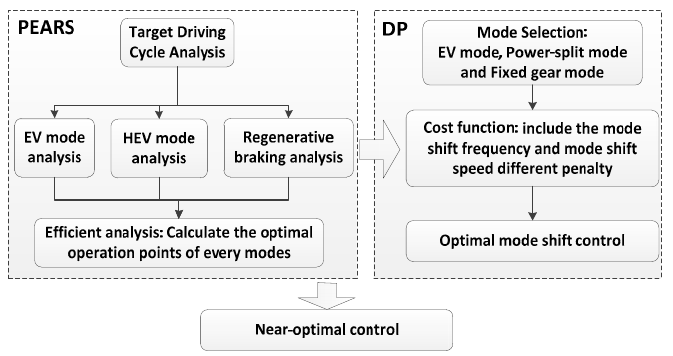
Figure 5. Procedure of the near ‐ optimal control PEARS+.